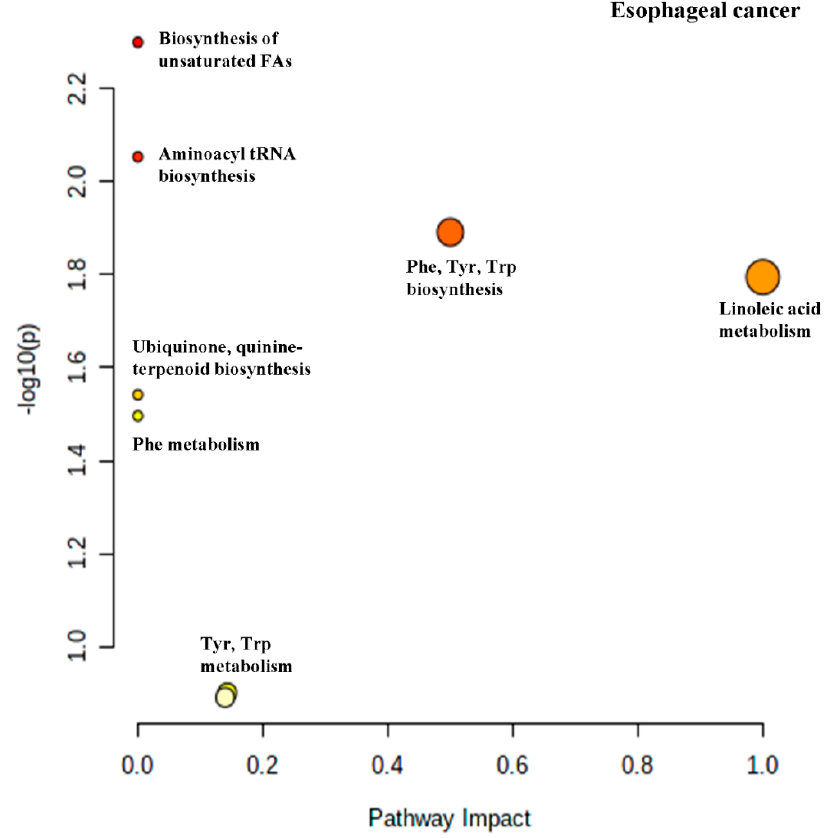
Figure 5. Pathway analysis performed using the altered metabolites from metabolomics data for esophageal cancer (EC) (refer to the legend of Figure 4 for the diagram explanation).